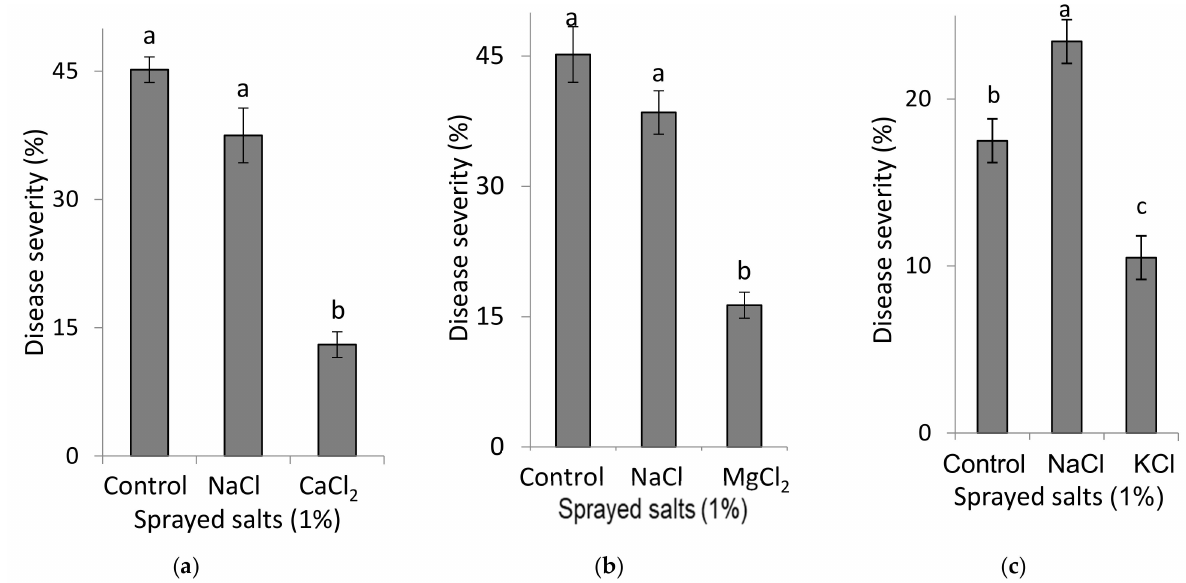
Figure 5. Effects of foliar applications of 1% salt solutions on the severity of sweet basil downy mildew (SBDM): ( a ) NaCl and CaCl 2 , ( b ) NaCl and MgCl 2 and ( c ) NaCl and KCl. SBDM severity was evaluated on a 0–100% scale, in which 0 = healthy plants and 100% = plants completely covered by disease symptoms/signs. Data derive from 3 trials ( n = 5). Values followed by a different letter are significantly different according to two-way ANOVA with Tukey’s HSD. Default significance levels were set at α = 0.05. Bar = SE.